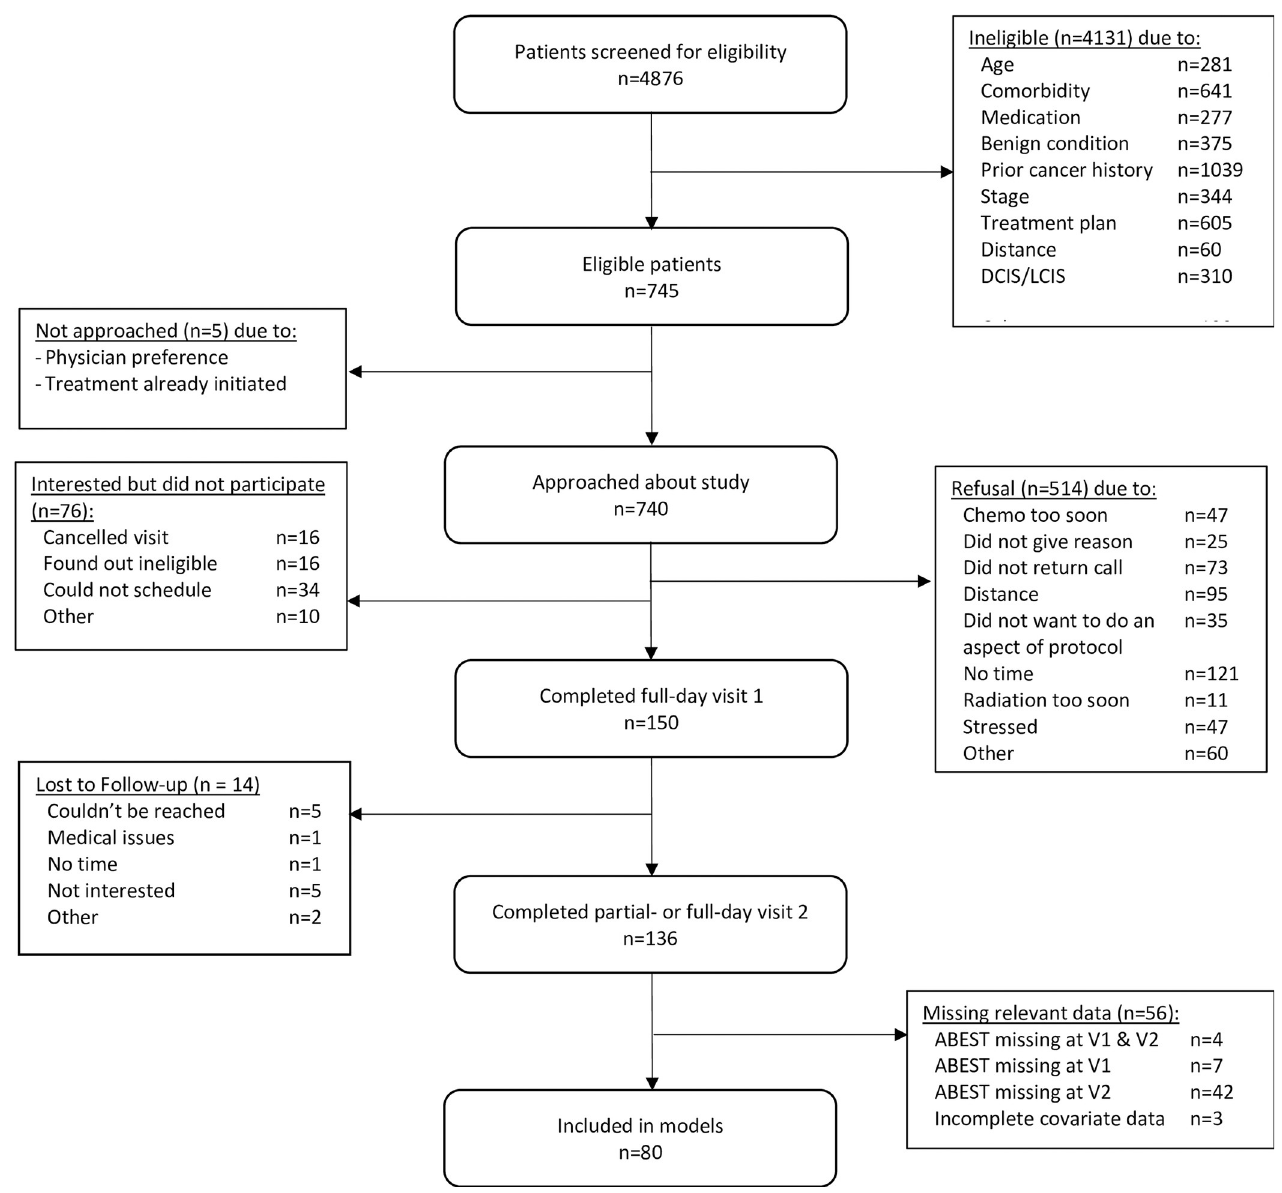
Fig 1. Flowchart of participants through